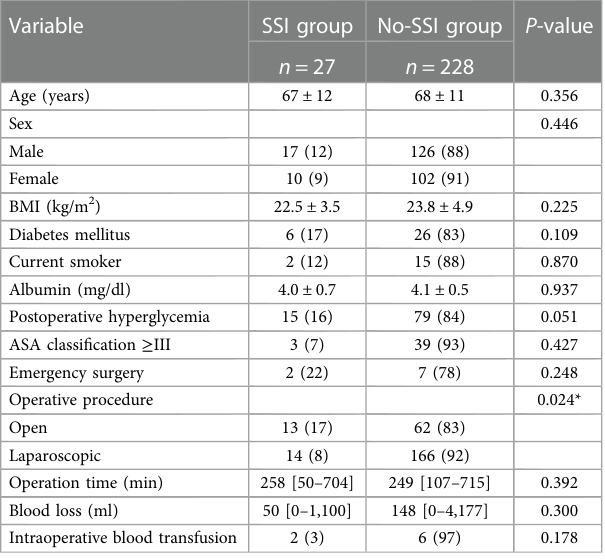
TABLE 4 Clinical characteristics of SSI vs. no-SSI groups among patients who underwent colorectal surgery ( n =255).